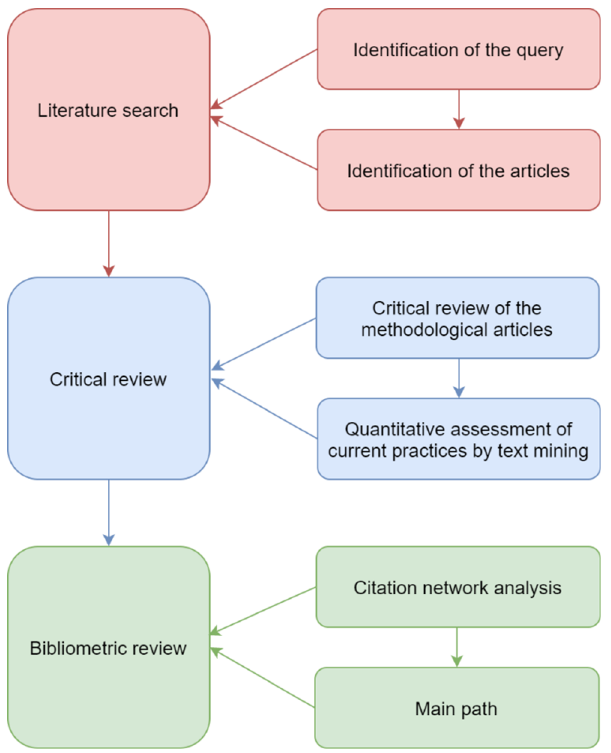
Figure 1. The three steps followed in the literature review.